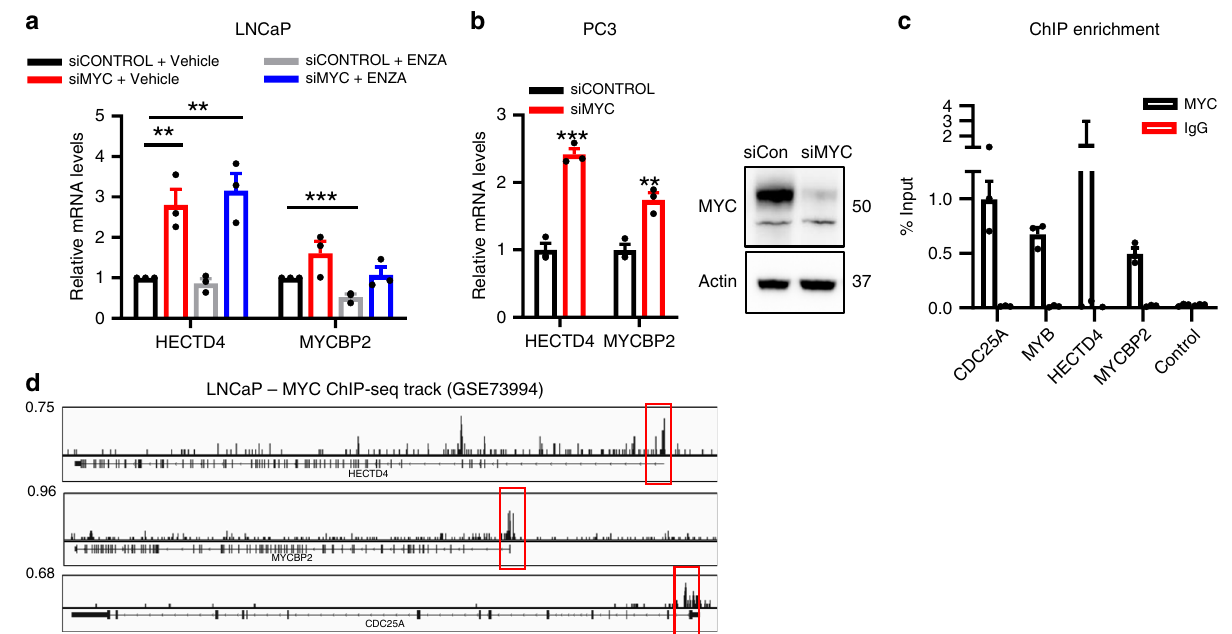
Fig. 6 MYC loss induces expression of HECTD4 and MYCBP2 . a mRNA expression of HECTD4, MYCBP2 in LNCaP cells transfected with Control or MYC targeting siRNA (2 days) followed by treatment with Vehicle or 20 μ M ENZA (2 days). b mRNA expression of HECTD4, MYCBP2 and TRIM49 in PC3 cells transfected with Control or MYC targeting siRNA for 2 days. c MYC ChIP followed by qPCR in LNCaP cells at the promoters of the indicated genes. d MYC ChIP-seq plots in LNCaP cells (GSE73994) at the indicated genes. Statistical tests: p value determined by two-tailed t test ( a , b ). Error bars represent S.E.M. n = 3 independent experiments ( a – c ). ** p < 0.01; *** p <